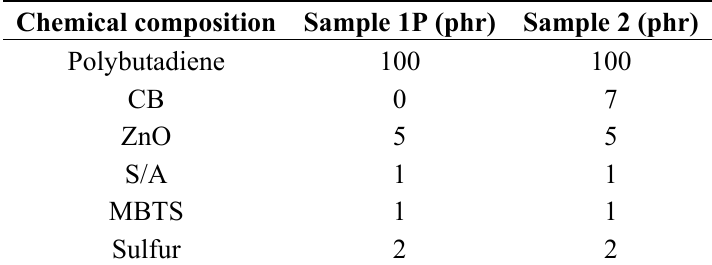
Table 4. Composition for the two samples of polybutadiene (the unit is